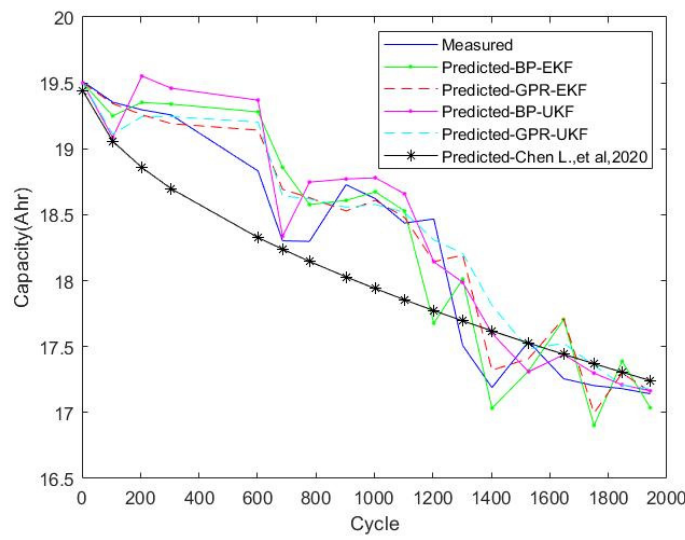
Figure 8. Prediction for battery based on cycling test cycles [19]. Table 3. Comparison of different algorithms based on cycling test cycles.